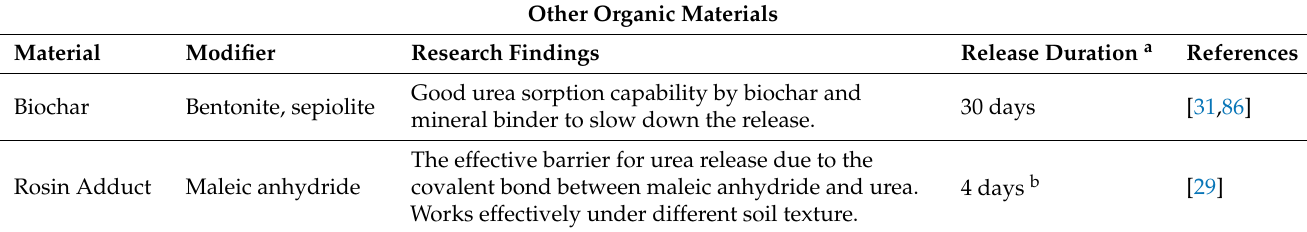
Table 4. CRFs coating from other organic